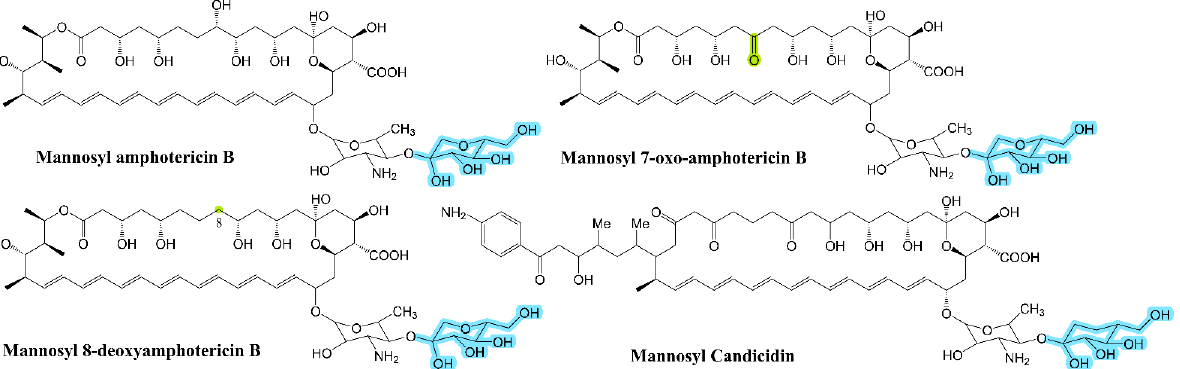
Figure 7. Polyene structure with additional glycosyl added by NypY; highlights represent differ- ences from the initial compound. from the initial